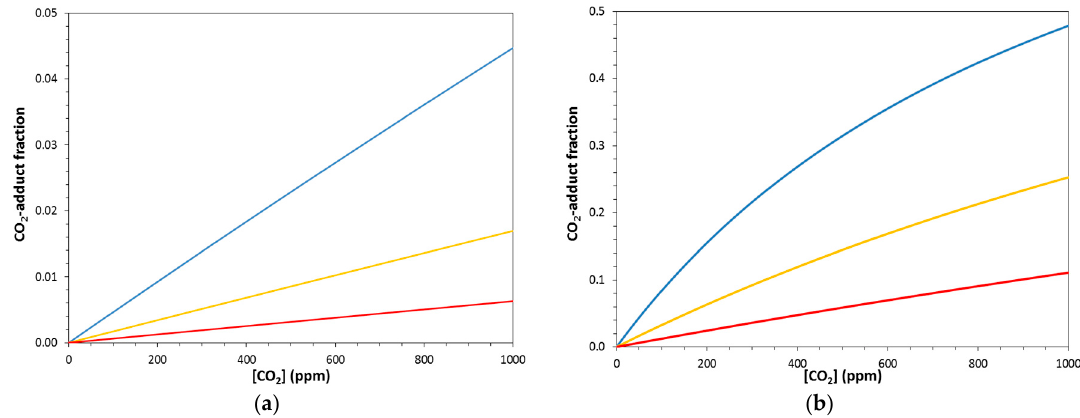
Figure 7. Fraction of CO 2 -adduct remaining in capture solution at equilibrium at 338.15 K (= T ° + 40) for the RCR-type reactions ( a ) HR2 with Δ G ° = − 9 kcal/mol and ( b ) HR3 with Δ G ° = − 11 kcal/mol. Reactions HR2 and HR3 are shown with entropies Δ S ° of − 20.12 ( blue ), − 36.89 ( yellow ), and − 53.66 cal/(mol·K) ( red ).